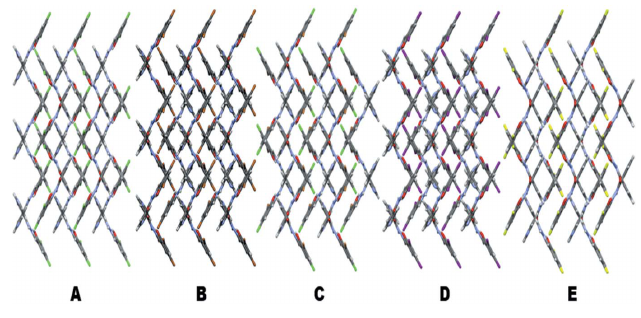
Figure 12 Packing of molecules in the halogen derivatives A to E to show the similarity.